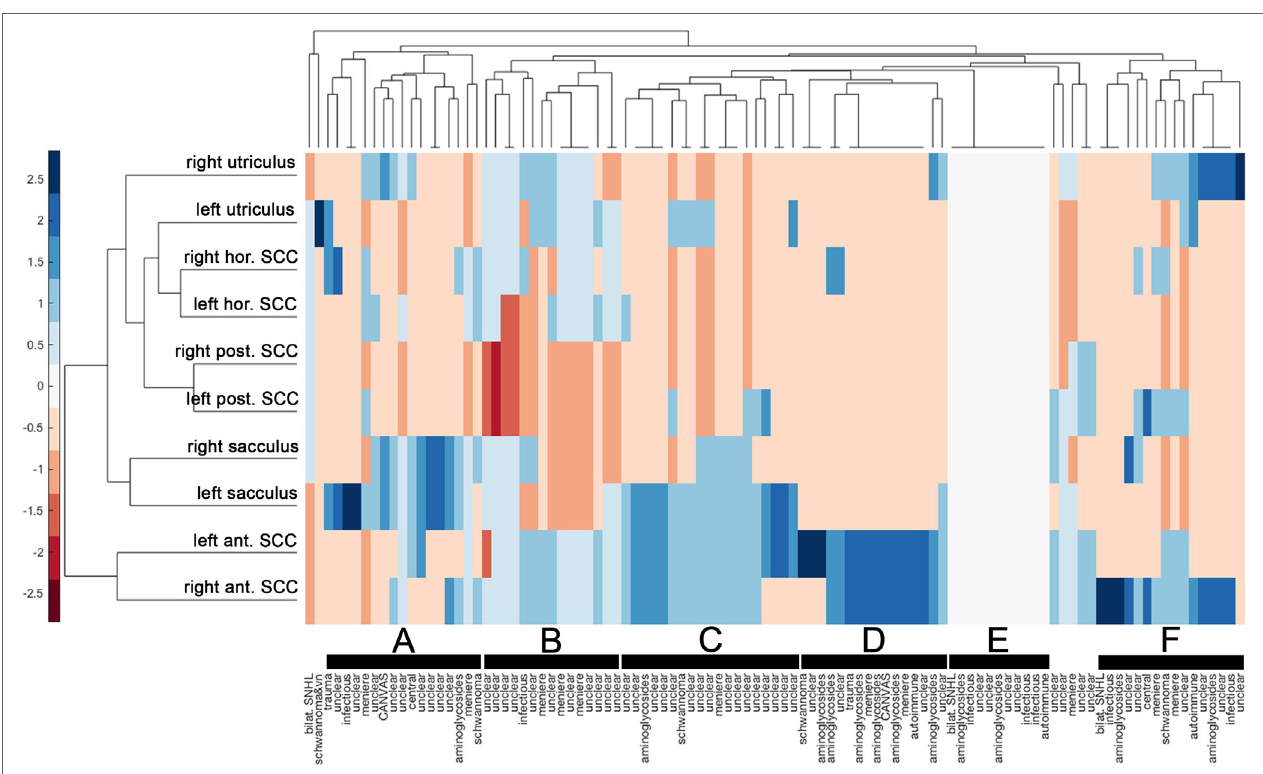
FigUre 6 | Hierarchical cluster analysis based on the overall rating (intact vs. impaired) of each vestibular end organ. A heat map indicates the functional state [from intact ( = blue) to deficient ( = red)] for each vestibular end organ ( n = 10) and patient ( n = 101). The heat map was clustered by Euclidean distance. The data were standardized along the columns of data, i.e., for the individual results from single subjects, resulting in a range of colors between 2.5 (blue) to − 2.5 (red) as indicated by the legend on the left side. Diagnosis in each patient is provided along the x -axis. Cluster dendrograms indicate those patients ( x -axis) and vestibular end organs ( y -axis) that are the least different, as these groups cluster together first. Cluster analysis identified 5 clusters with at least 15 patients (nodes A, B, C, D, and F) and one smaller cluster (node E), which are all marked with black